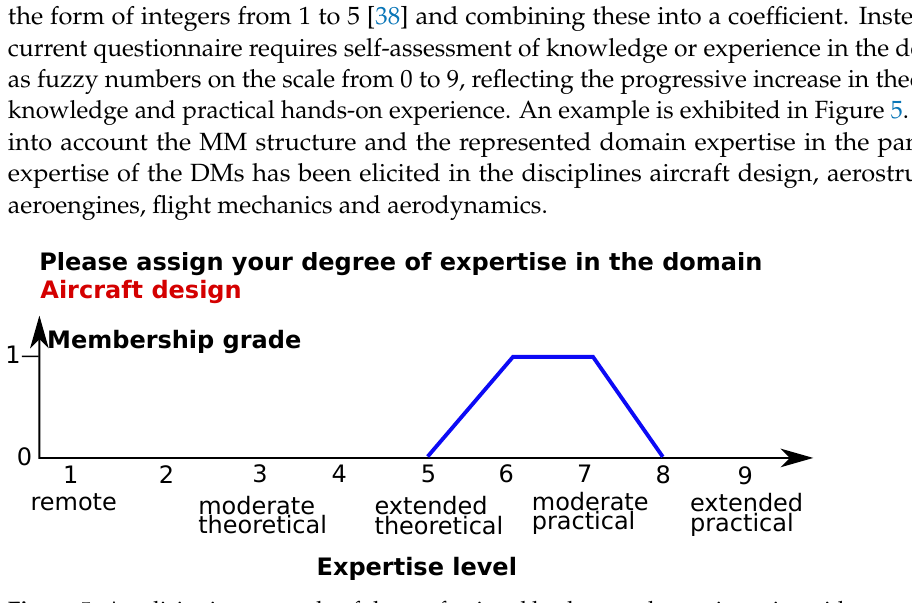
Figure 5. An elicitation example of the professional background questionnaire with a trapezoidal fuzzy